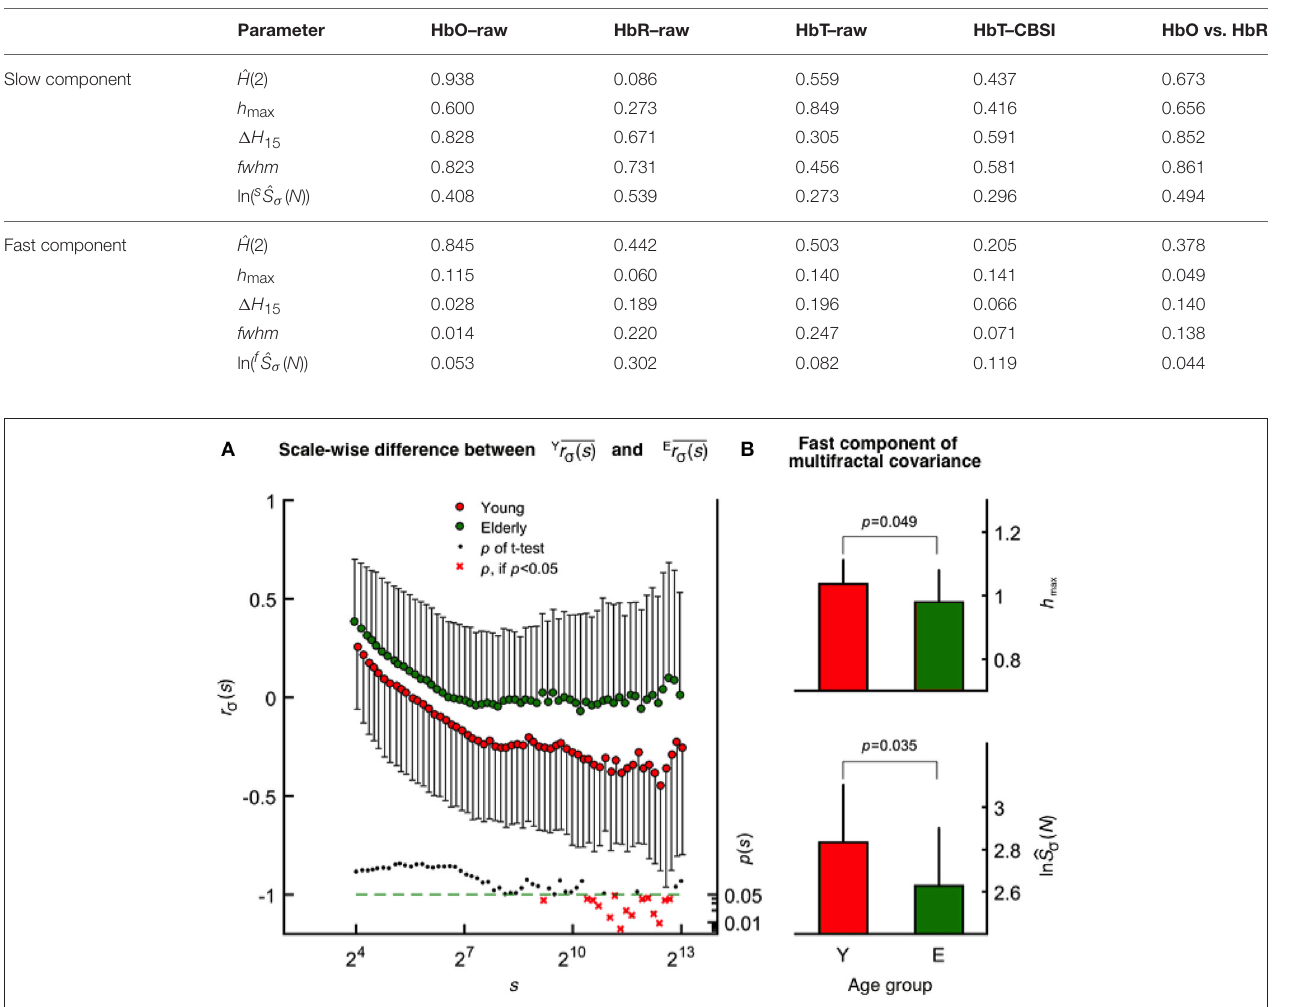
FIGURE 4 | Age-related differences revealed by scale-wise and scale-free analysis of oxy- and deoxyhemoglobin relationship. (A) Fractal correlation coefficient of HbO and HbR as functions of scale in the elderly (upper) and young (middle) groups with the corresponding p -values (lower). At s min , these were above 0 and decreased gradually toward-1 as s approached s max in both age groups. (B) Multifractal covariance of f h max (upper) and ln( f ˆS σ ( N ); lower) of the fast component in the young and elderly groups.